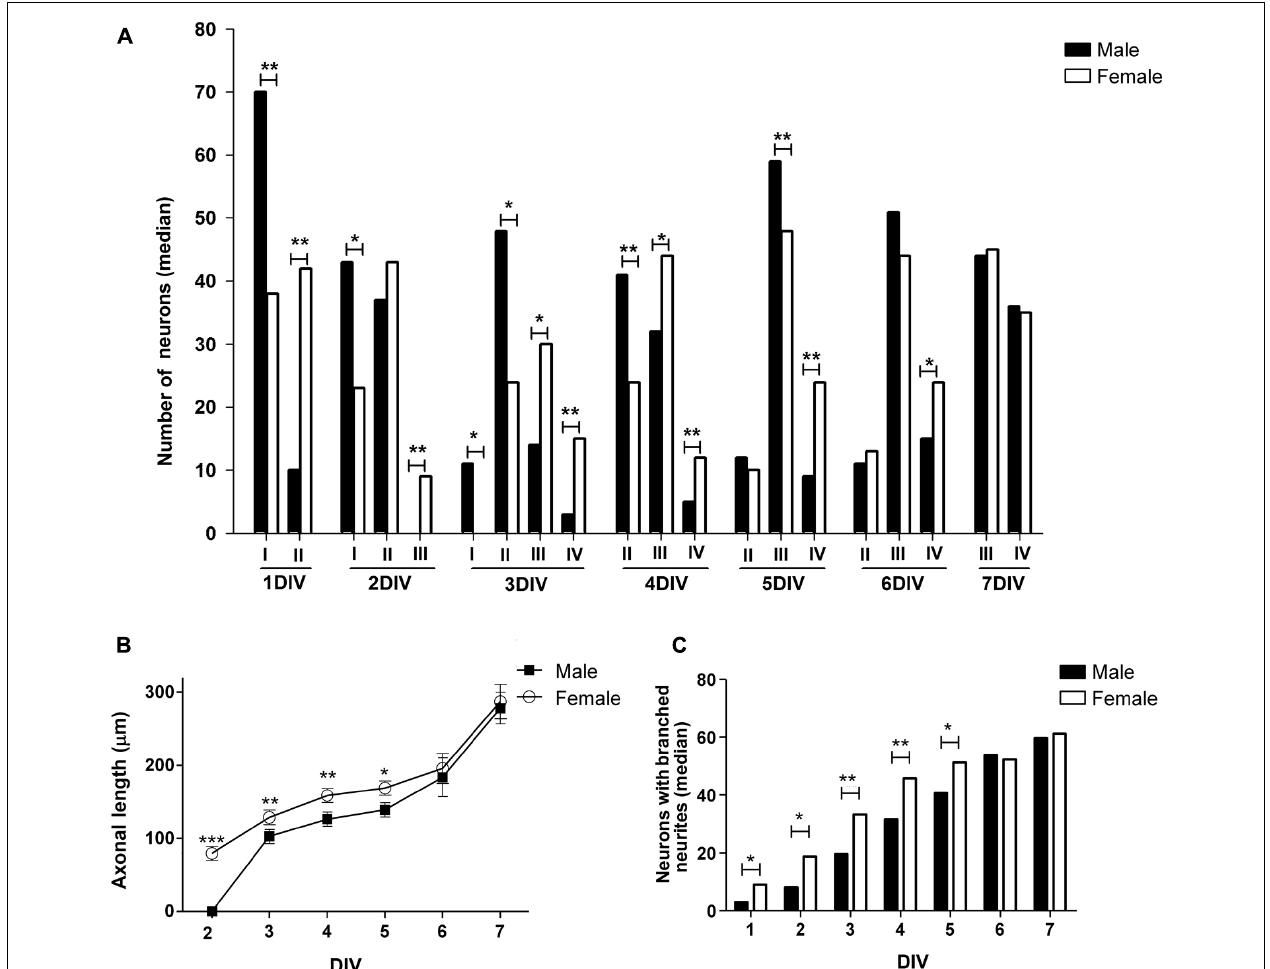
FIGURE 3 | Changes over time in morphological parameters of hypothalamic neurons in sexually segregated cultures maintained from 1–7 days in vitro (DIV). (A) Median number of neurons at different stage of maturation: I, II, III, and IV (for references see caption in